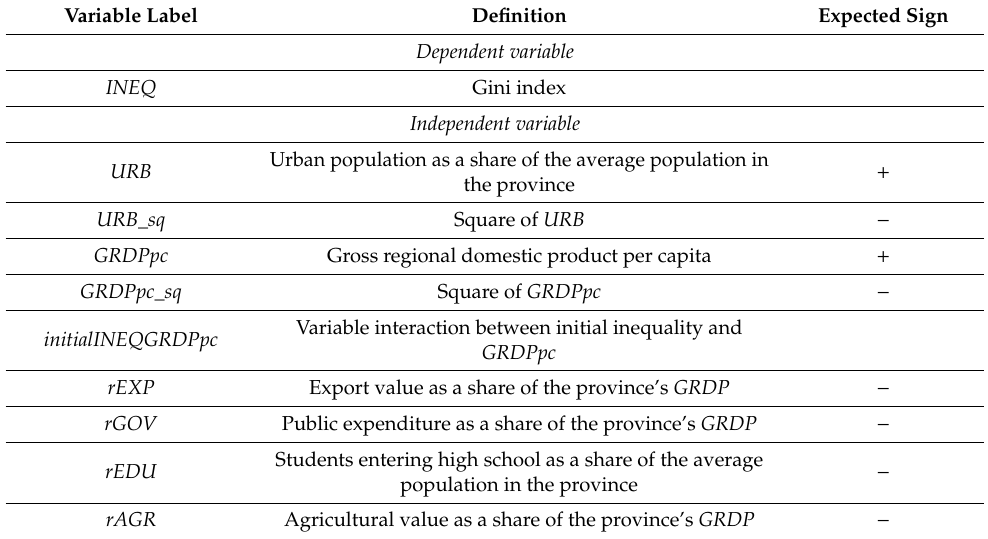
Table 1. Definition of variables in research